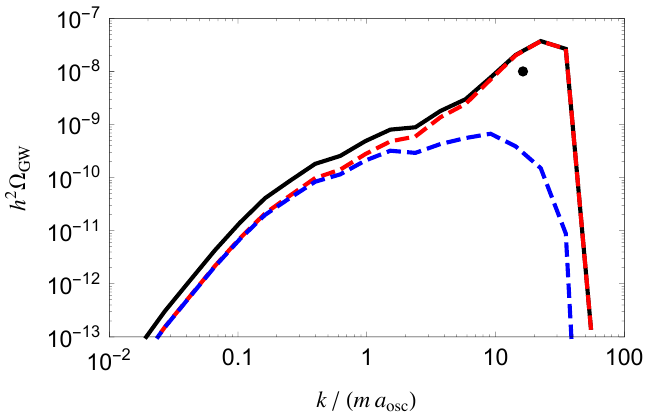
=(cid:26) 0 , except for the last benchmark point DM (cid:30)